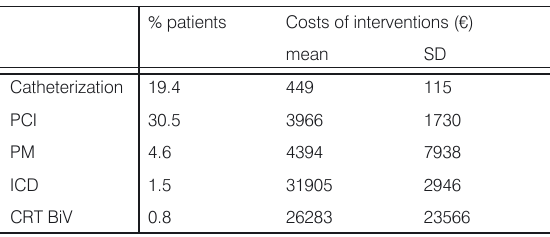
Table 3. Costs of interventions; mean values with standard deviation (SD).